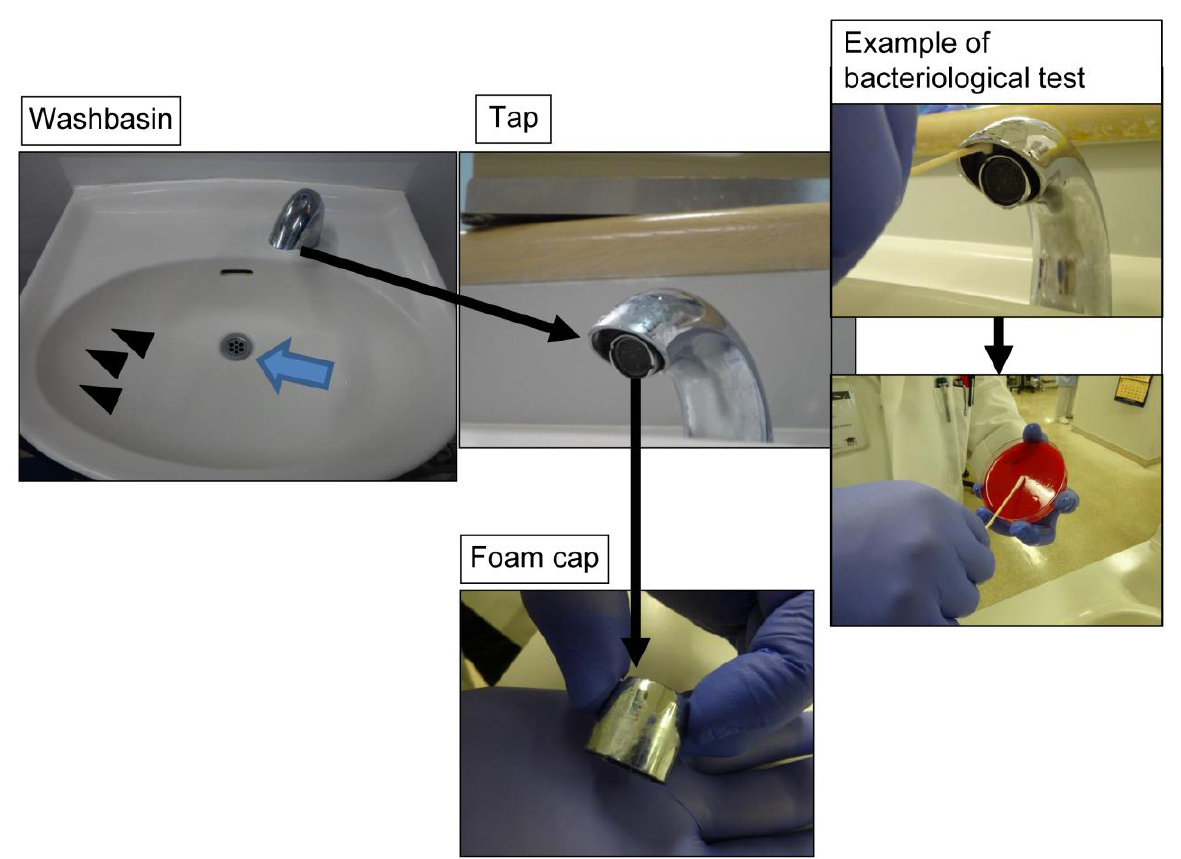
Figure 1. Bacteriological survey of washbasin units. We conducted a bacteriological survey of the drain (blue arrow), the sides of the sink (arrowheads), and the tap of washbasins in the high-care unit of the Advanced Emergency and Critical Care Center. The taps had a foam cap on the inside. Samples were collected from the tap for bacteriological testing by simultaneously wiping the inner foam cap and the inside surface of the tap with a sterile cotton swab.